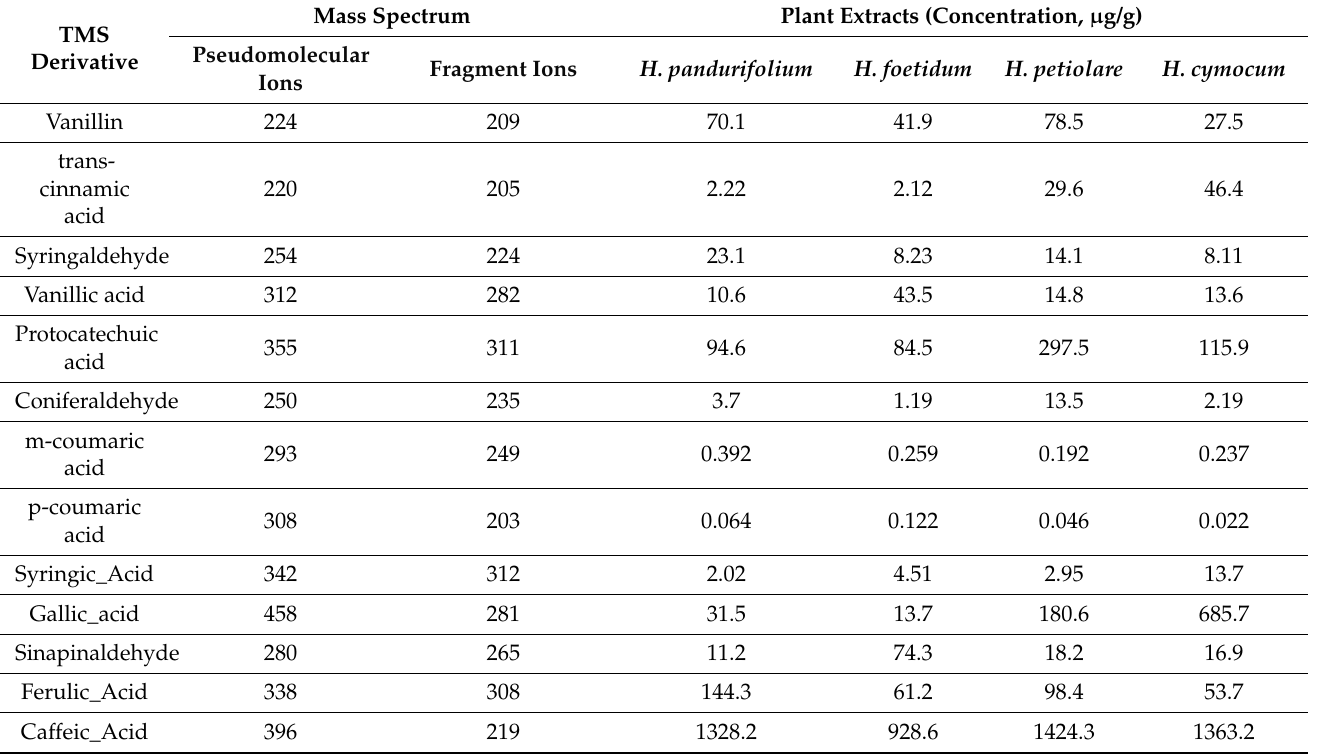
Table 4. Phenolic acid and phenolic aldehyde composition ( µ g/g) of the acetone extracts of